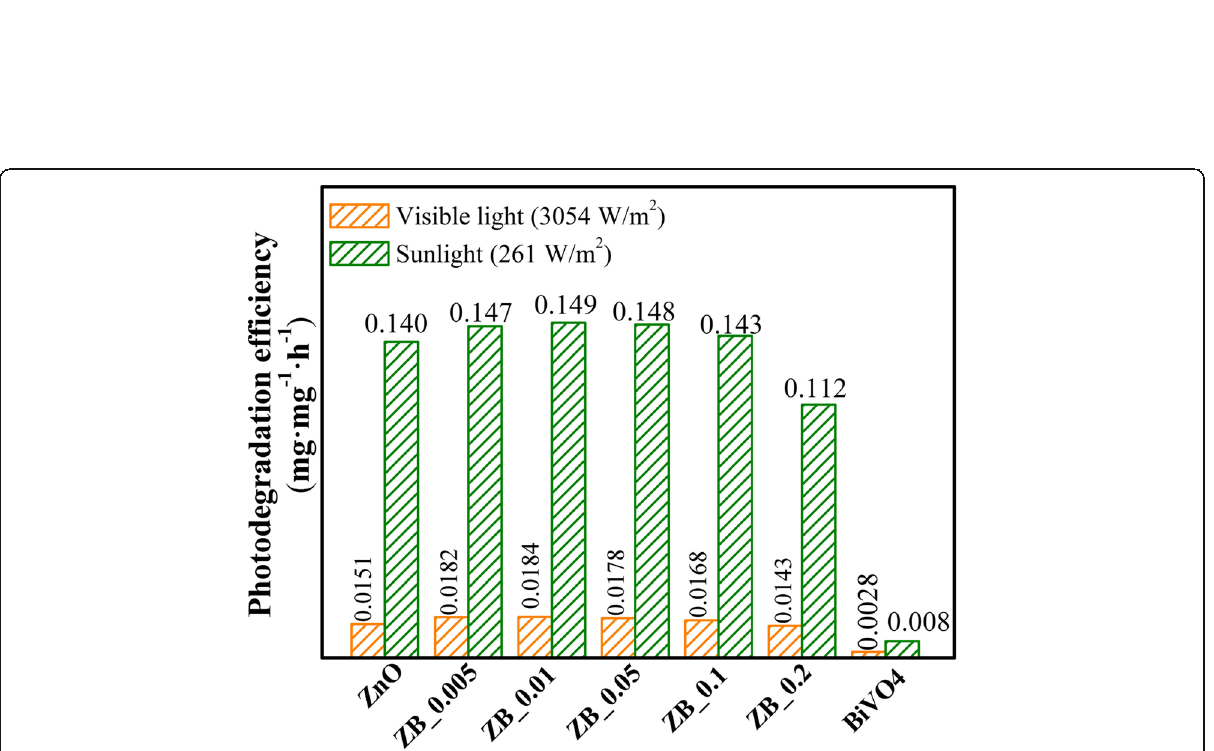
Fig. 9 Photocatalytic degradation efficiency for ZnO, BiVO 4 , and BiVO 4 -modifying ZnO with different Bi/Zn molar ratios under visible light and natural sunlight